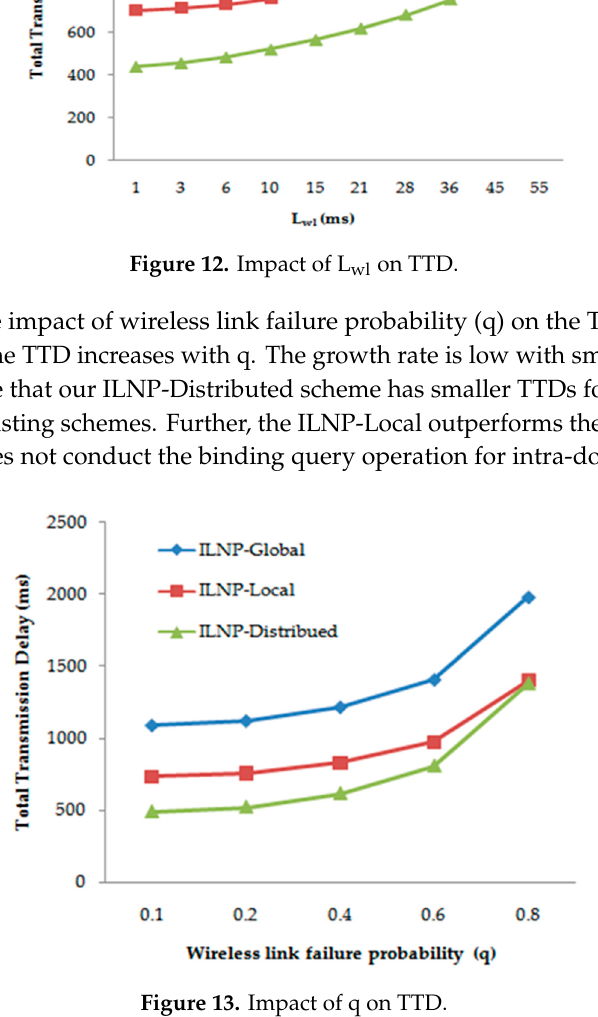
Figure 13. Impact of q on TTD.